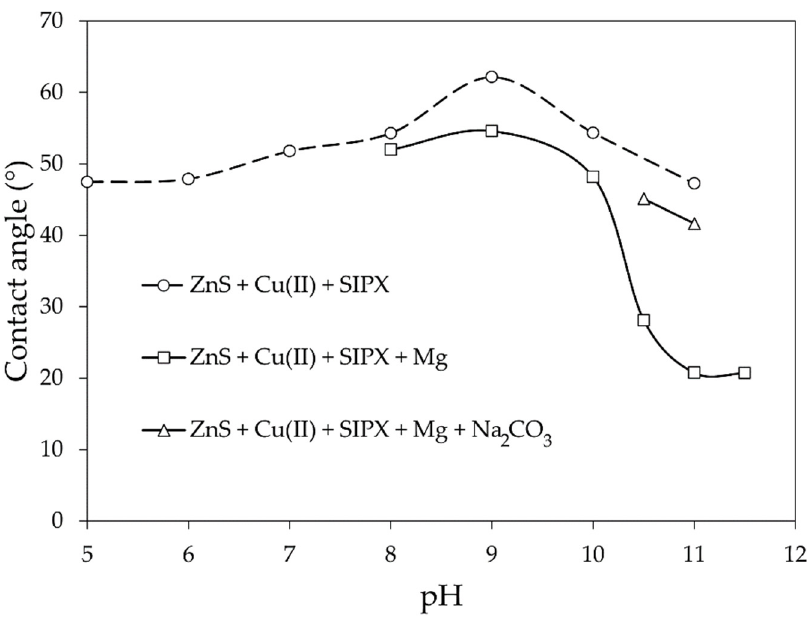
Figure 4. Effect of pH and magnesium (50 mg/L), on the contact angle of Cu-activated (50 mg/L, 15 min) sphalerite further conditioned with SIPX (10 − 4 mol/L, 5 min) at 25 °C. It is also shown the effect of sodium carbonate, added during xanthate conditioning (2 g/L), to counteract the detrimental effect of magnesium.